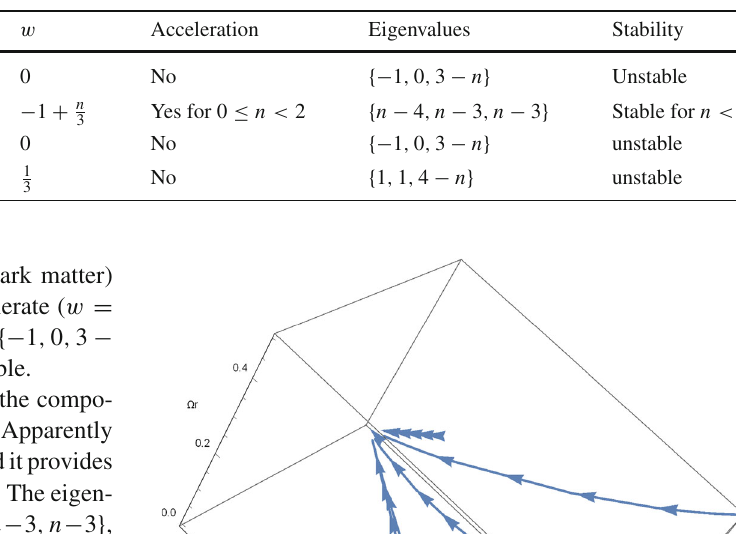
Table 3 Critical points and physical quantities for Case C